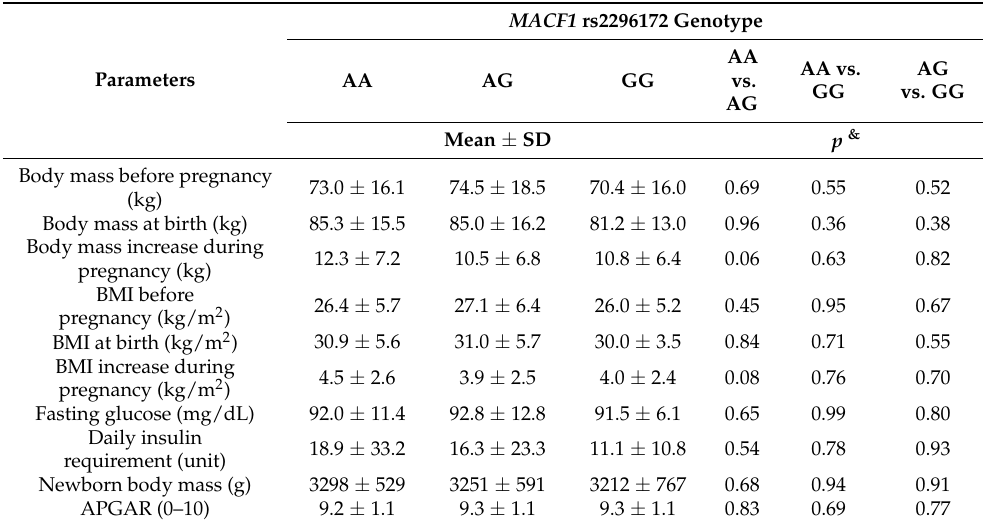
Table 4. Clinical parameters of women with GDM stratified according to MACF1 rs2296172 genotype [21–23].